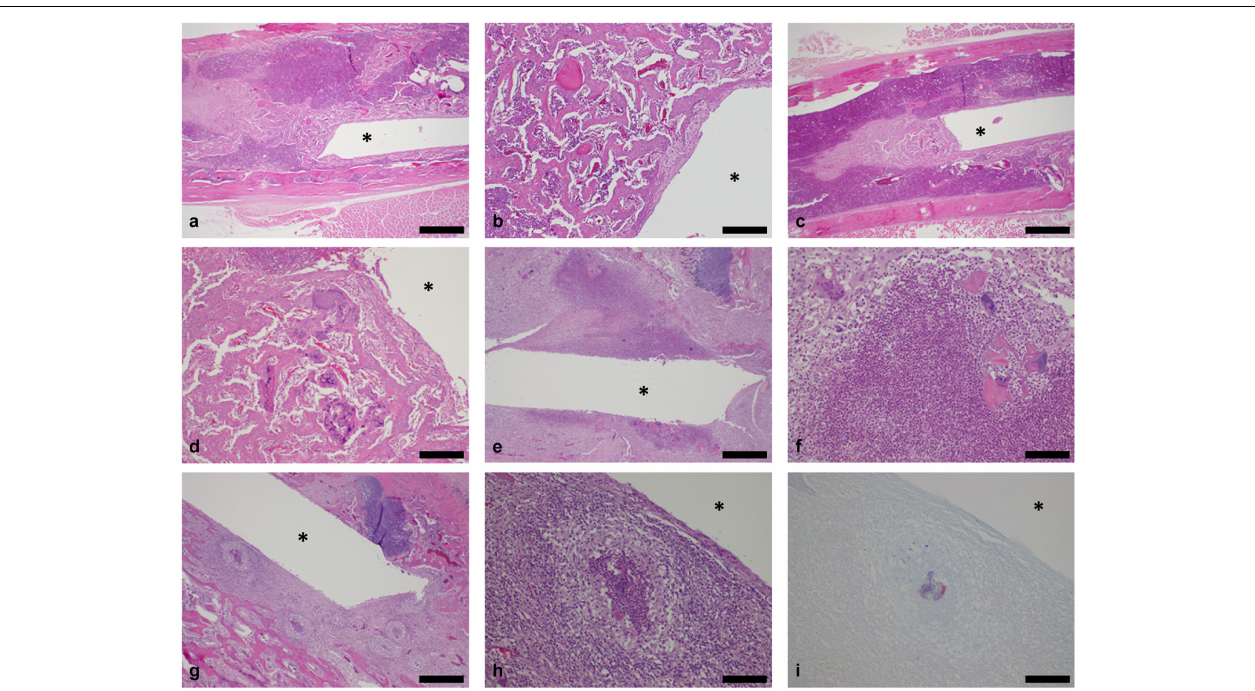
FIGURE 3 | Histological longitudinal sections of right tibiae. Orientation: proximal tibia is to the right side and distal tibia is to the left side ( ∗ : location of original K-wire implant tract). Control implants, day 8: Low (a) and high magnification (b) showing bone necrosis and new bone ingrowth along the pin tract at the metaphysis/diaphysis junction, extending into the diaphysis. No inflammation or bacteria were observed (H&E stain; bars: 1 mm and 200 µ m respectively). Similar findings were observed at day 15 (images not shown). Low-dose implants, day 8: Low (c) and high magnification (d) showing bone necrosis/dust and new bone ingrowth along the pin tract at the metaphysis/diaphysis junction, extending into the diaphysis. No inflammation or bacteria were observed (H&E stain; bars: 1 mm and 200 µ m respectively). Similar findings were observed at day 15 (images not shown). High-dose implants, day 8: Low (e) and high magnification (f) showing marked suppurative inflammation and bone necrosis along the pin tract in the metaphysis. The core of degenerated neutrophils (suppurative inflammation) is surrounded by a layer of macrophages, lymphocytes and occasional multinucleated giant cells (mixed inflammation; H&E stain; bars: 500 and 100 µ m respectively). High-dose implants, day 15: Low (g) and high magnification (h) showing multifocal to coalescing micro-abcesses and bone necrosis along the pin tract in the epiphysis and metaphysis. Micro-abcesses consisting of a core of degenerated neutrophils and bacteria are surrounded by a thick layer of macrophages and mononuclear cells (H&E stain; bars: 500 and 100 µ m respectively). (i) Intra and extracellular Gram-positive bacteria (cocci; Gram’s Twort stain; bar: 100 µ